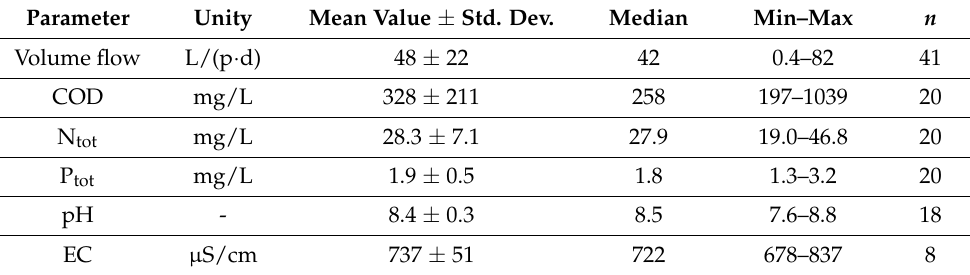
Table 2. Volume flow and composition of screened light greywater (showers and washbasins) from container-based workers’ accommodations in Stuttgart North.